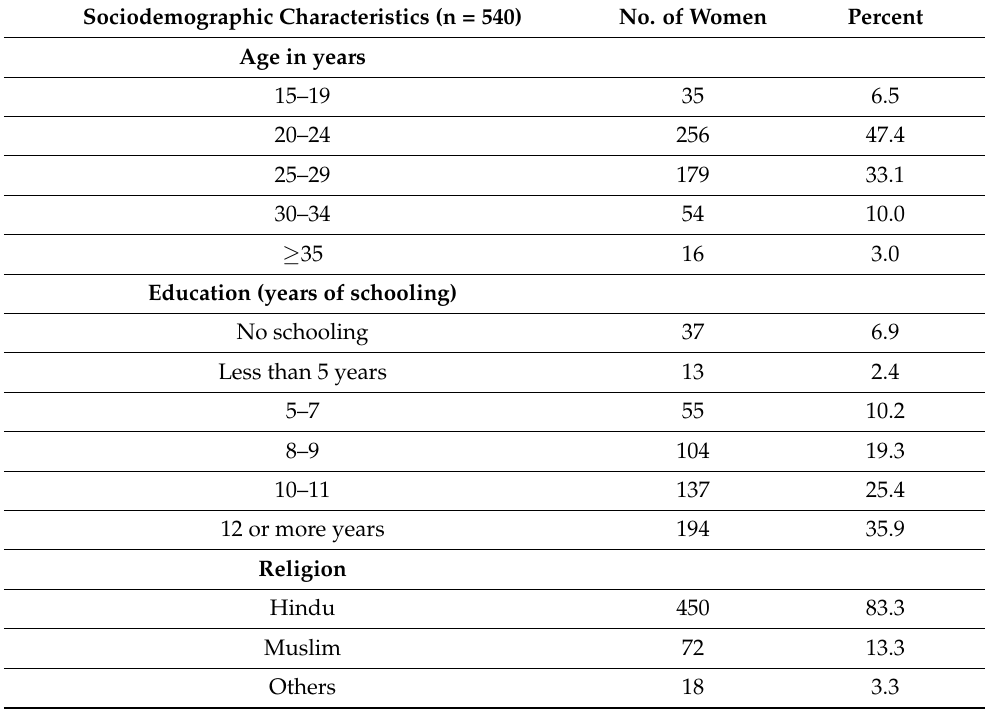
Table 1. Sociodemographic profile of the patients (n = 540) from six states of India, March–June 2020. Sociodemographic Characteristics (n =